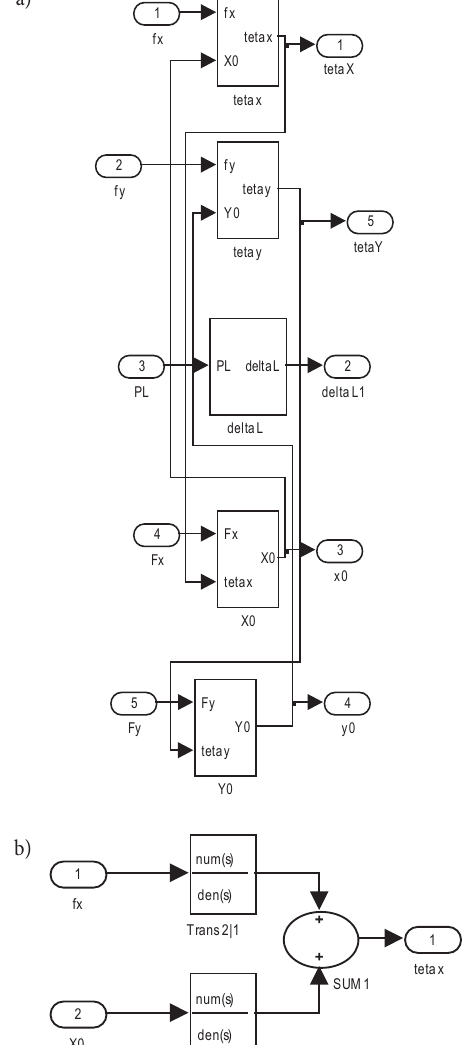
Fig. 2. The model of the mechanical part (a); the model of the subsystem where the angle Θ x is taken into account